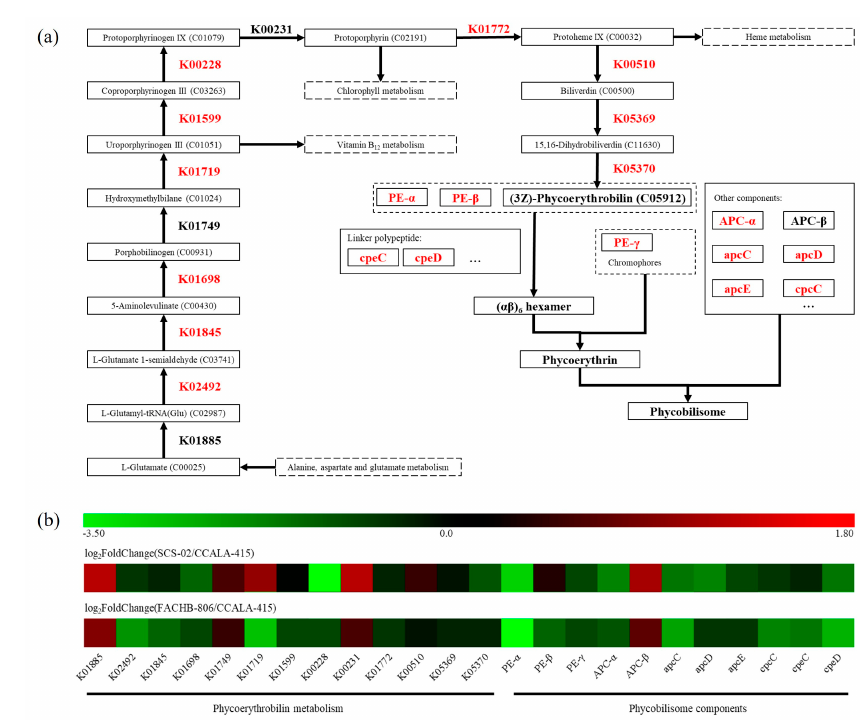
Foods 2022 , 11 , x FOR PEER REVIEW Up: the expression of gene is up-regulated. Down: the expression of gene is down-regulated. Porphyridium cruentum CCALA-415 is the control. Porphyridium purpureum SCS-02 and Porphyridium purpureum FACHB-806 are treatment group.